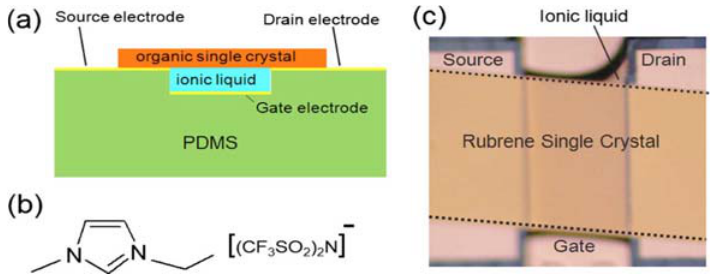
Figure 14. Color online ( a ) Structure of organic crystal/ionic liquid transistors. ( b ) [emim][TFSI]. ( c ) Optical view of a rubrene crystal/emimTFSI transistor [76]. Reprinted with permission from ref. [78]. 2012 American Institute of Physics.